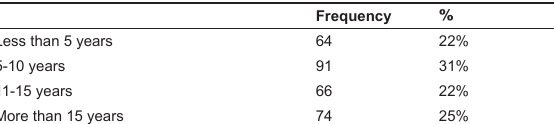
TABLE 3 Number of years with the institution ( n =